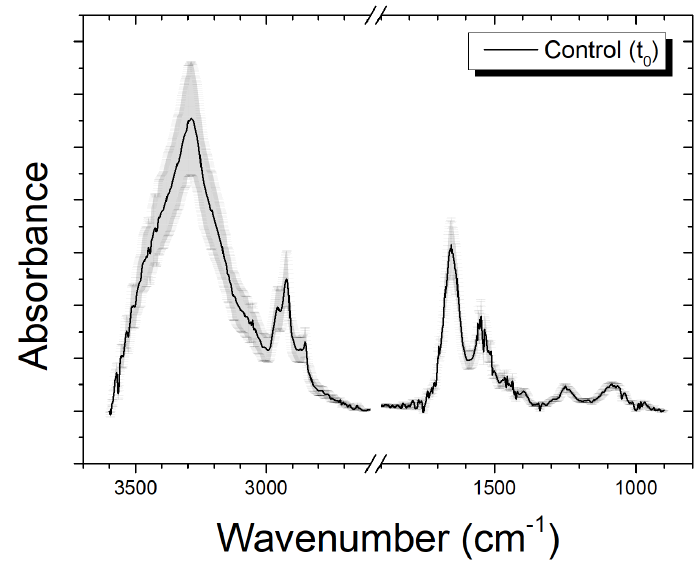
Figure 1. Average spectrum of an unexposed sample in the range 3600–900 cm − 1 ; the break at 2600–1900 cm − 1 hides a region without interesting signals from biological molecules; data are presented as MEAN ± SD.